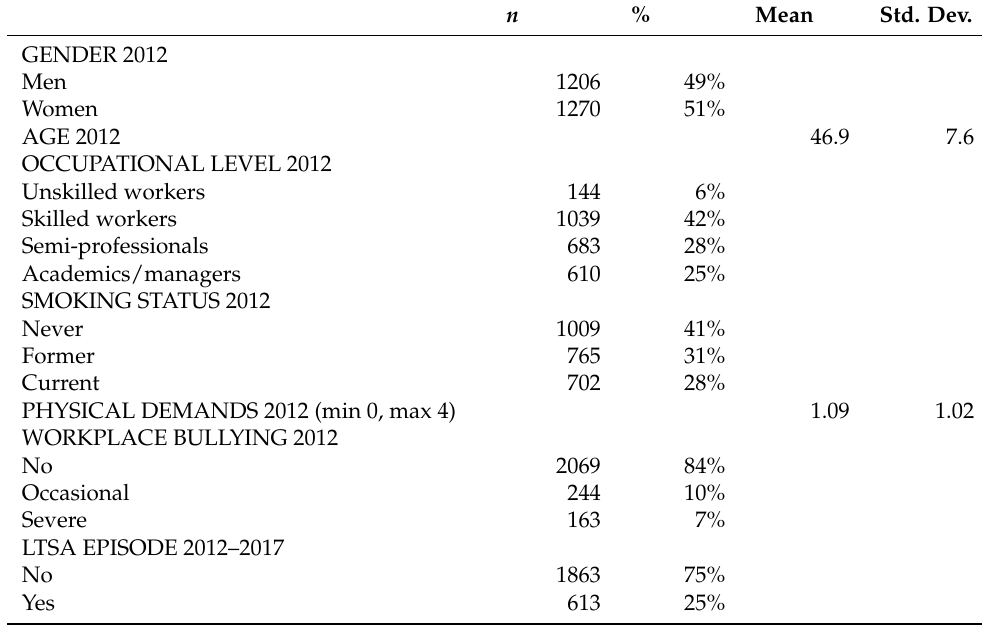
Table 1. Distribution of independent and depent variables among among 2476 employees aged 31 to 60 years in Germany in 2012. n % Mean Std.